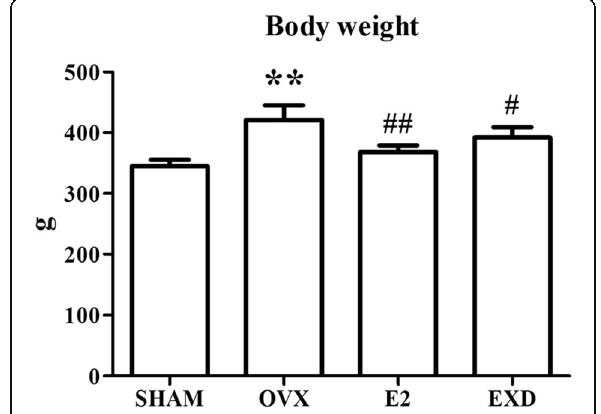
Fig. 1 Effect of EXD on body weight after 12-week treatment. ** P <0.01 versus SHAM group; # P < 0.05 versus OVX group; ## P < 0.01 versus OVX group